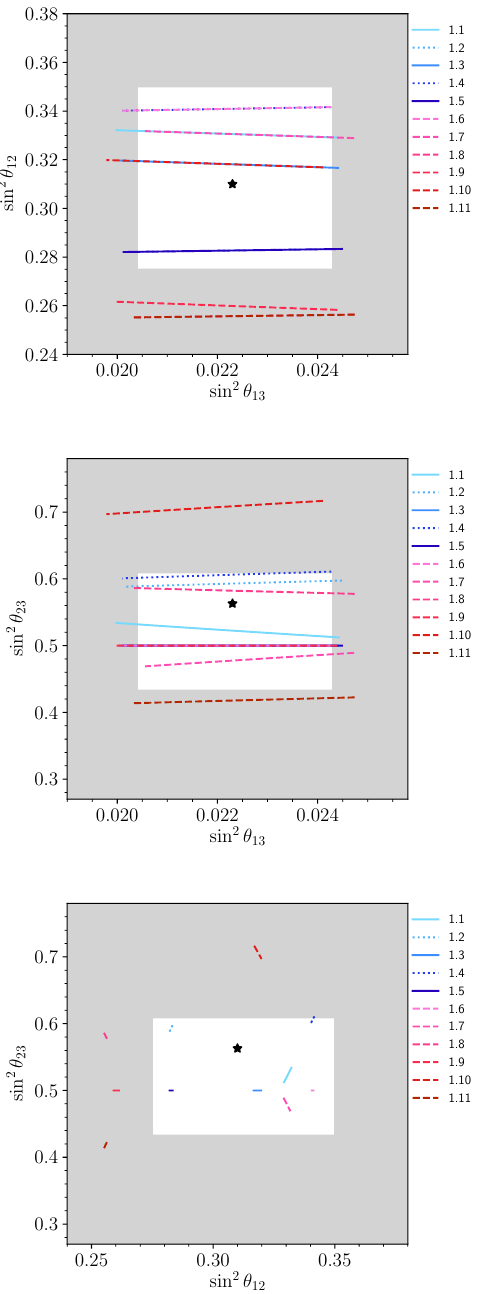
Figure 1 . Prediction of leptonic mixing angles for the eleven one-parameter models. The lines show the allowed values of the leptonic mixing angles for the 3 (cid:27) intervals (cid:18) 3 (cid:27) of the respective model parameters (cid:18) given in table 8. The white areas show the allowed 3 (cid:27) regions of the leptonic mixing angles from (cid:12)ts to global neutrino oscillation data, whereas the gray-shaded areas show the corresponding excluded regions. A star (\ ? ") indicates the present best-(cid:12)t values of the leptonic mixing angles from global neutrino oscillation data. Top panel: sin 2 (cid:18) 13 -sin 2 (cid:18) 12 . Middle panel: sin 2 (cid:18) 13 -sin 2 (cid:18) 23 . Bottom panel: sin 2 (cid:18) 12 -sin 2 (cid:18) 23 .